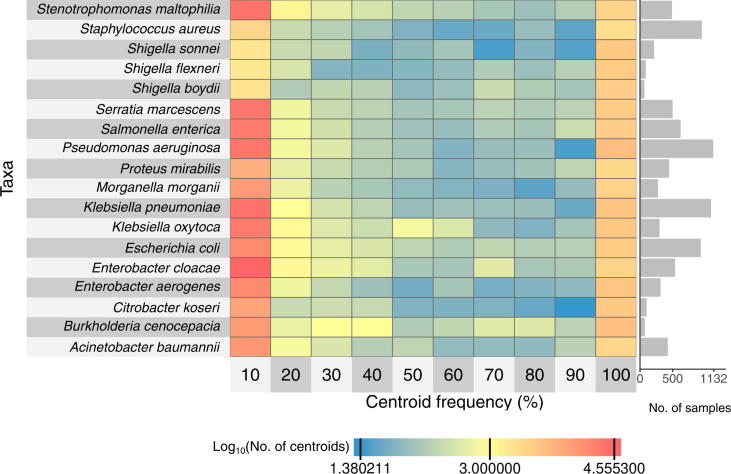
Centroid frequencyNumber of centroids in each pan-genome of the 18 main species in relation to their frequency. The first column contains centroids that are present in <10% of the isolates, and the last one contains centroids that are present in ≥90% of the isolates. Cells are coded in color gradient to indicate the log10-transformed number of centroids. The bar plot on the right shows the number of isolates used to construct the respective pan-genomes.